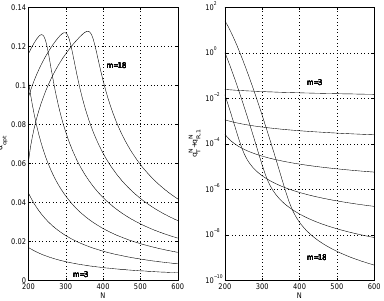
Figure 6. Cross-sections of q T ( α,N,m ) N + q R, 1 ( α,N,m,r 0 ) N for α = 0 . 1 , r 0 = 0 . 1 and m = 3 , 6 , 9 , 12 , 15 and 18 .